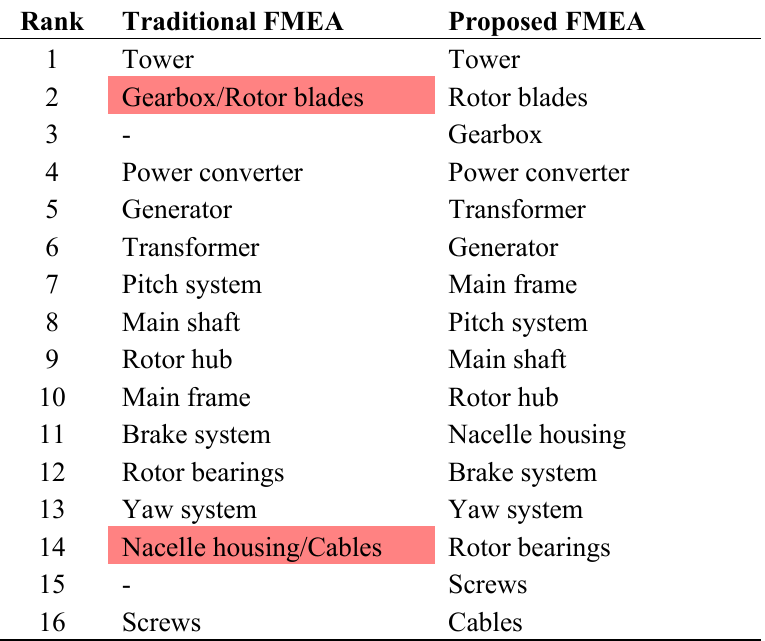
Table 12. Ranking comparisons between “RPN” and “CPN”. Rank Traditional FMEA